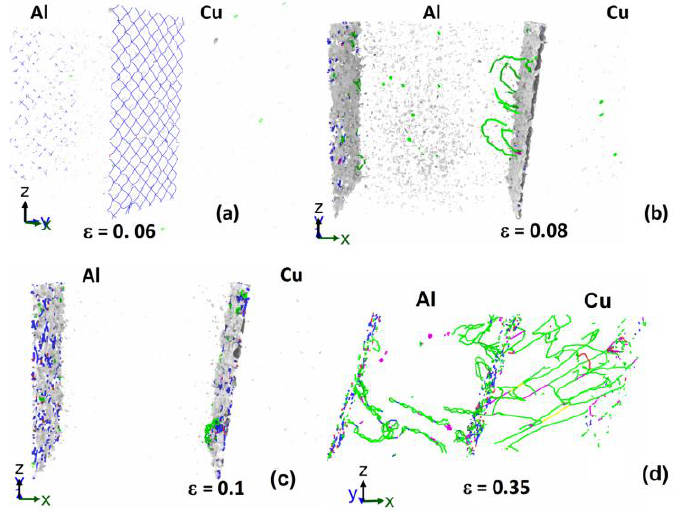
Figure 21. Development of plastic deformation in Al-Cu composite with the (100) interface at zero initial pressure and elevated temperature of 700 K: ( a ) A grid of perfect dislocations at the interface; ( b ) violation of the structure of the interface and emission of split perfect dislocations in Al; ( c ) absorption of dislocation by the interface; ( d ) dislocations in Al and twinning interlayers in Cu.